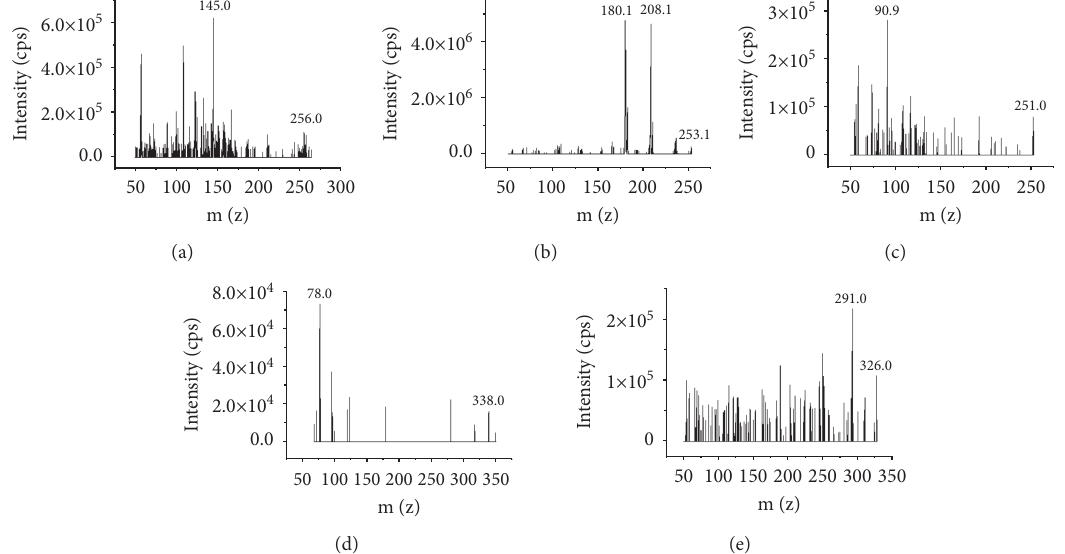
Figure 2: Mass spectrum of lamotrigine (a), oxcarbazepine (b), lacosamide (c), topiramate (d), and internal standard